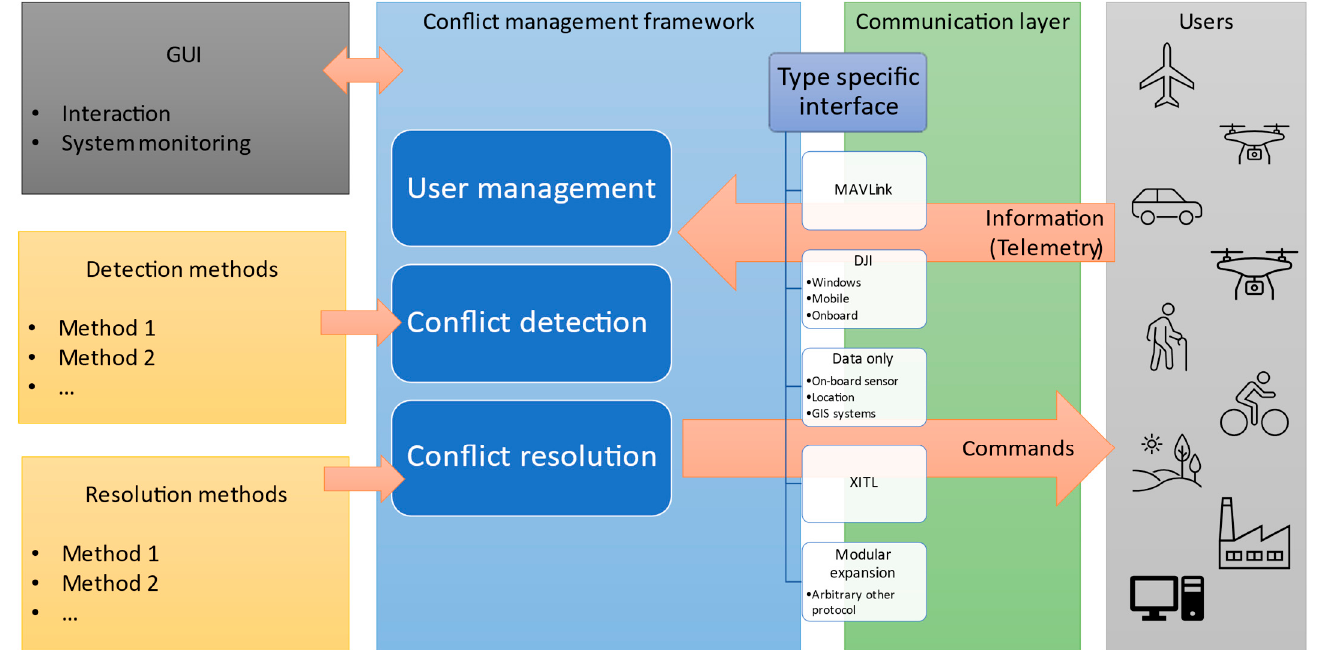
Figure 1. Conflict management system high level architecture.